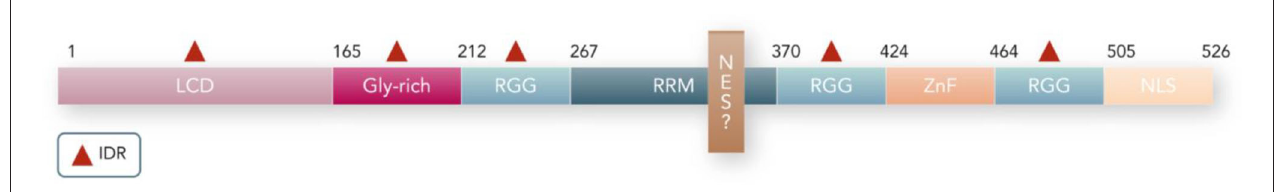
FIGURE 1 | Protein domains in FUS. The FUS folded domains are: RRM, ZnF (Zinc Finger), NLS (Nuclear location signal). In addition, NES (nuclear export signal) is a putative domain that may be located in the RRM domain. The FUS intrinsically disordered regions (indicated by a red triangle) are: Low complexity domain (LCD), Glycine-rich domains, and RGGs. The number of residues that covers each domain is